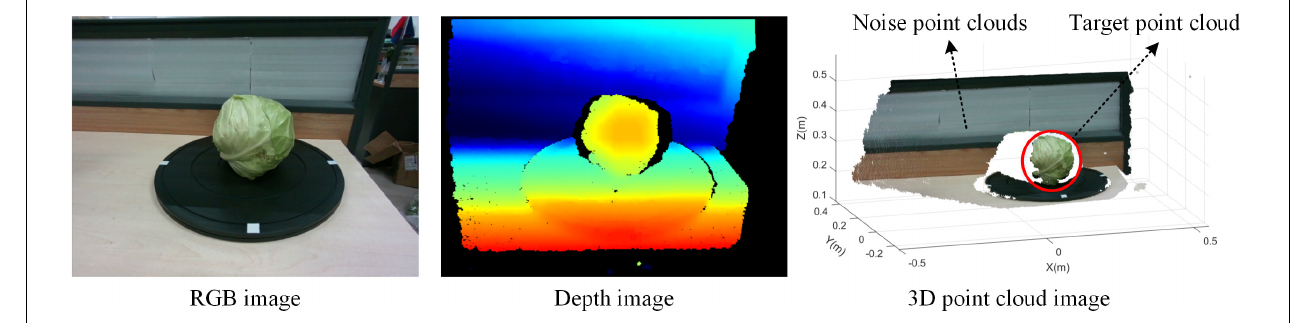
FIGURE 3 | Image fusion.